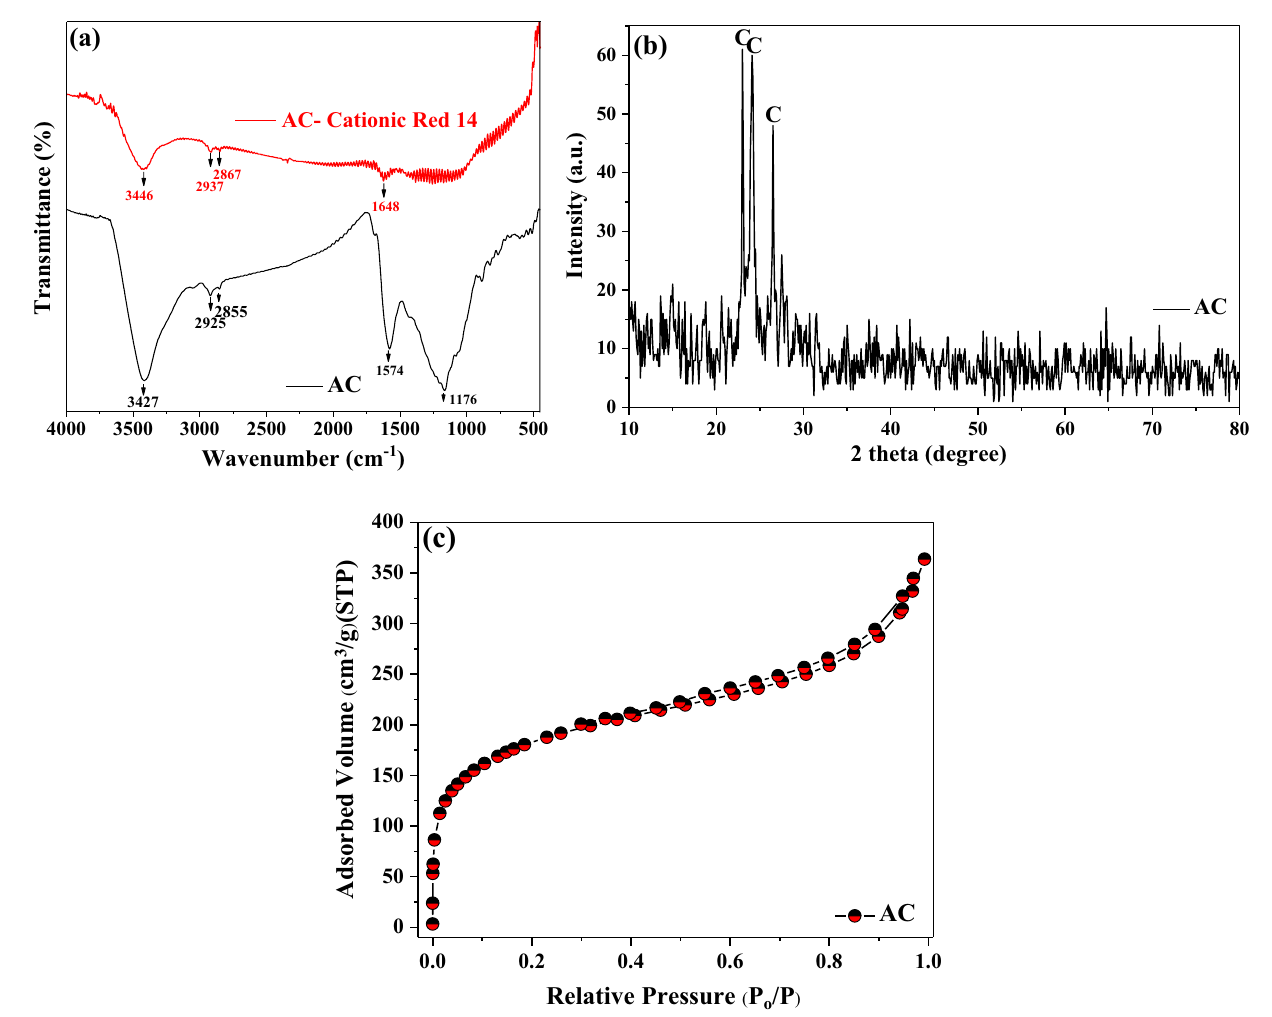
Fig. 1 RITF spectrum ( a ), XRD analysis ( b ) and nitrogen adsorption and desorption isotherm on activated carbon ( c